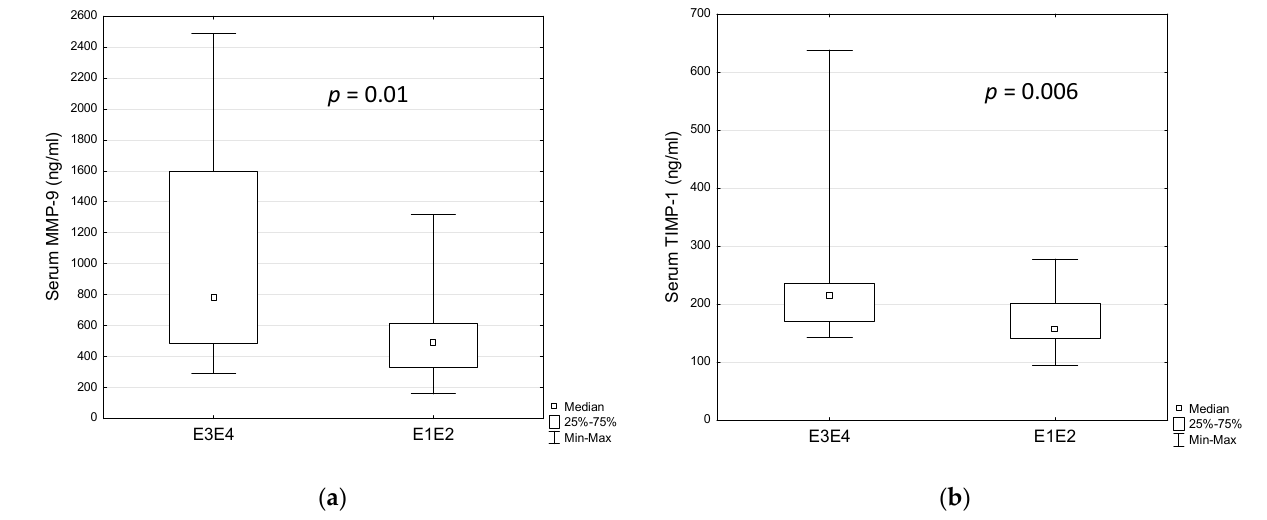
Figure 3. Differences in serum MMP-9 ( a ) and TIMP-1 ( b ) concentration regarding the extent of the disease (Paris classification). Statistical analysis by Mann–Whitney U test. MMP-9—matrix metal-